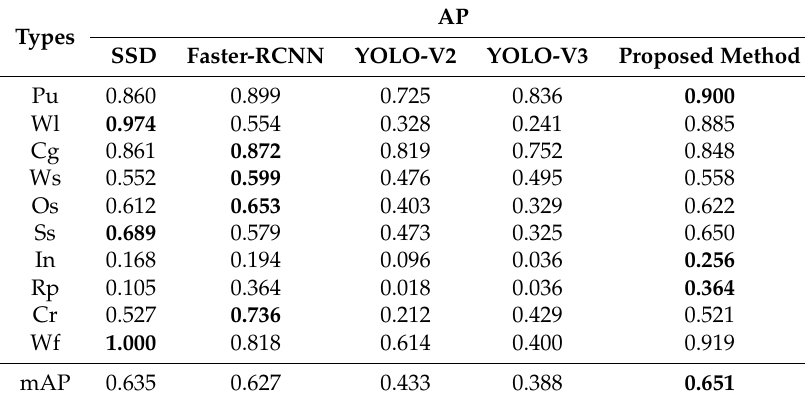
Figure 5. Detection results on the GC10-DET dataset. In sequence, the pictures are: ( 1 ) Crescent gap, ( 2 ) Welding line, ( 3 ) Water spot, ( 4 ) Silk spot, ( 5 ) Waist folding, ( 6 ) Inclusion, ( 7 ) Oil spot, ( 8 ) Crease, ( 9 ) Punching, and ( 10 ) Rolled pit. Table 5. Comparison of Average Precision (AP) on GC10-DET dataset. The proposed method performs the highest AP values for three defect categories. The proposed method also provides the highest mAP value. The bold helps to emphasize the highest